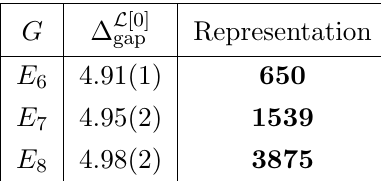
Table 9. Predicted gaps (the lowest scaling dimension) in the long multiplets in the Seiberg exceptional theories, and the (cid:13)avor group representations in which they